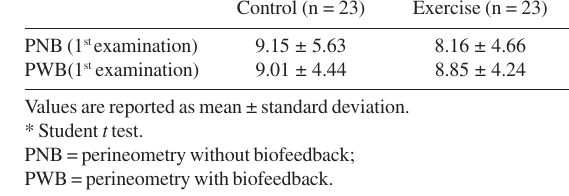
Table 7 - Spearman correlation coefficients between functional evaluation of the pelvic floor (FEPF) and perineometry with biofeedback (PWB) obtained at the first and second examinations (HCFMUSP. November 2003 to